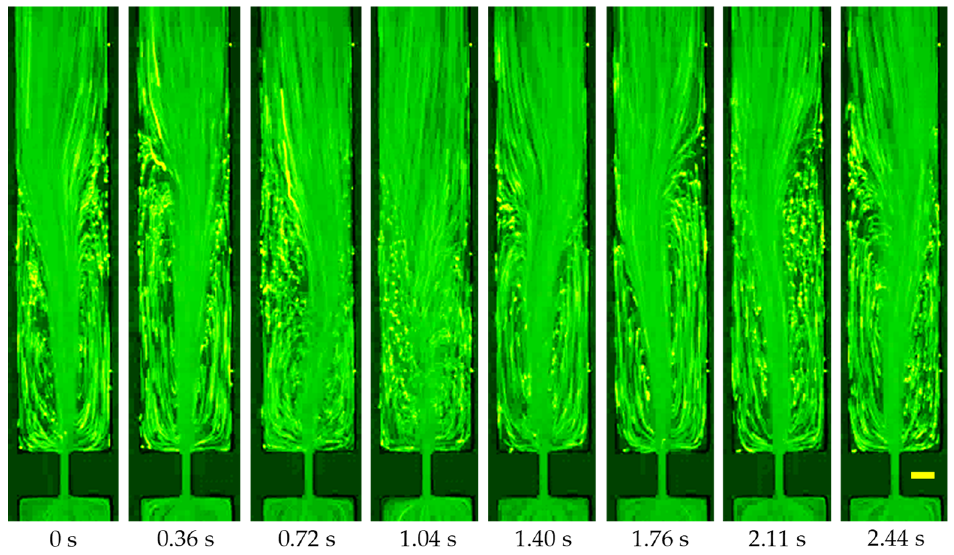
Figure 8. Demonstration of the unstable vortices in the flow of 200 ppm PAA solution at the contraction part of the microchannel under a flow rate of 0.5 mL/h. The scale bar represents 100 µm.